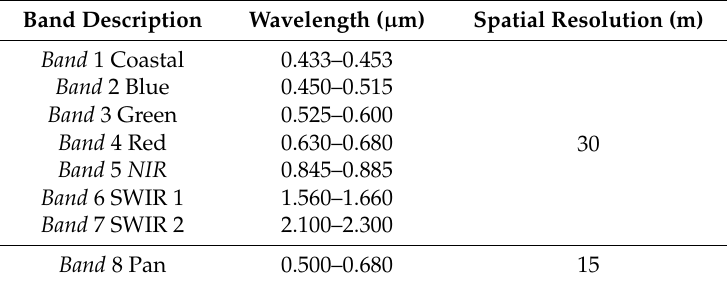
Table 1. Landsat 8 Operational Land Imager (OLI) band